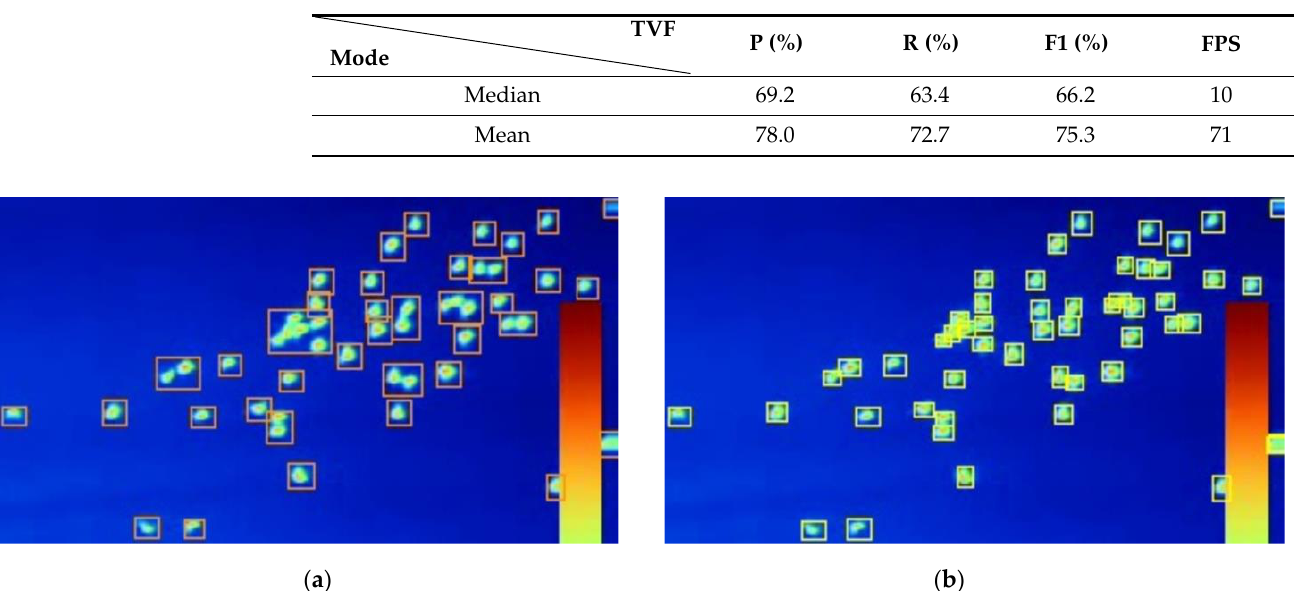
Table 5. Comparison detection results of median and mean mode used in TVF on our dataset.